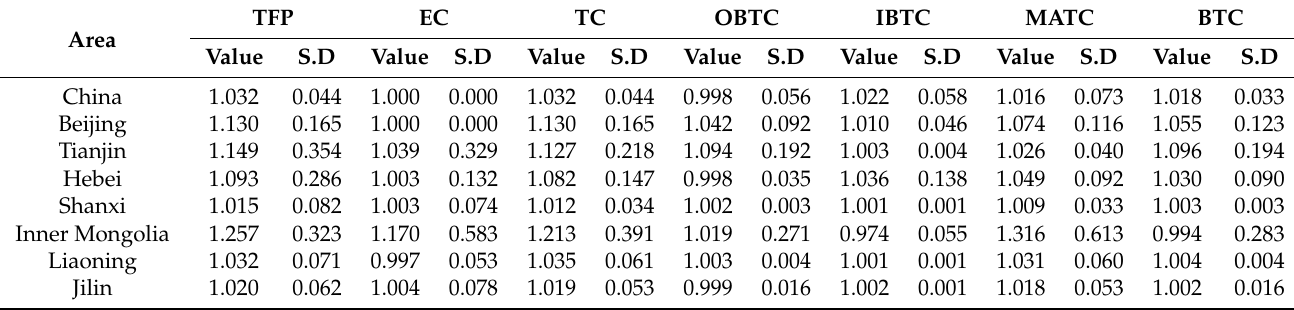
Table 3. Descriptive statistics of total factor productivity and its decomposition term for Chinese provinces.